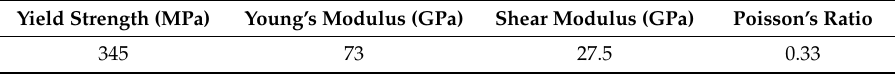
Table 2. Mechanical properties of Aluminum Alloy AA2024-T3.